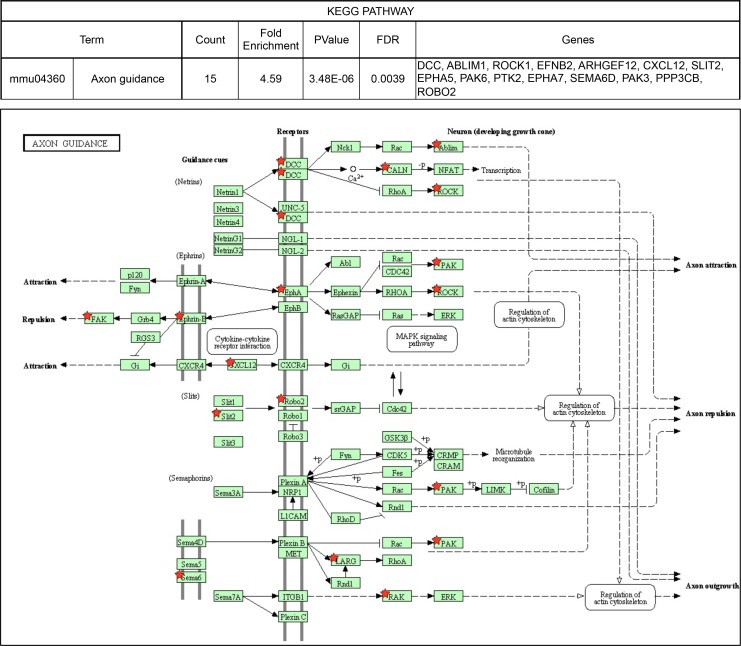
KEGG pathways over-represented among NOVA2-target genes.Axon guidance pathway (FDR<0.05). Red stars indicating NOVA2-target alternative splicing genes identified by combining RNA-seq with NOVA2 HITS-CLIP analysis. Figures obtained from GO analysis using DAVID Bioinformatics Resources (https://david.ncifcrf.gov).